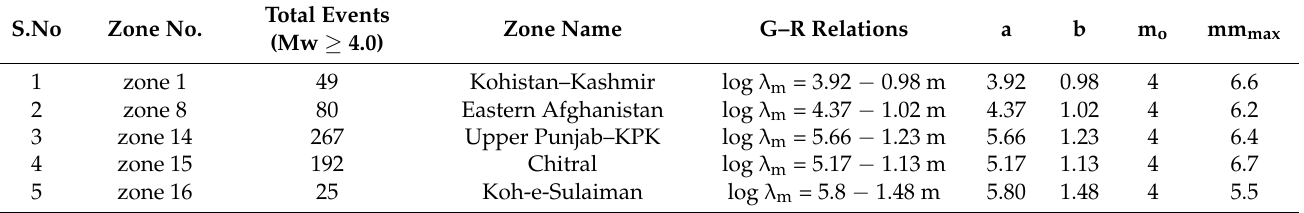
Table 4. Seismicity model of the study area.